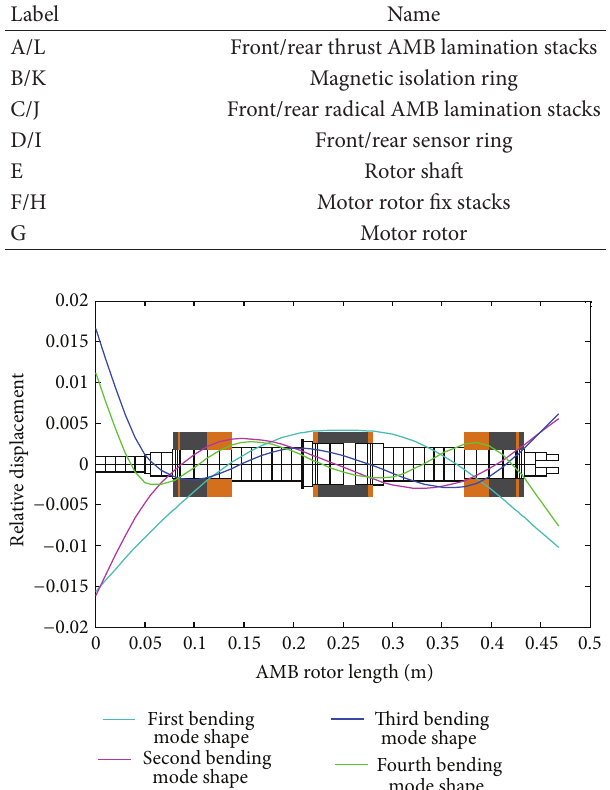
Figure 3: Theoretic mode shapes of free-free rotor.